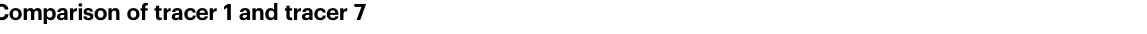
Table 2 | Comparison of tracer 1 and tracer 7 Tracer K d [µM] Protein conc. [µM] Tracer conc. [nM]